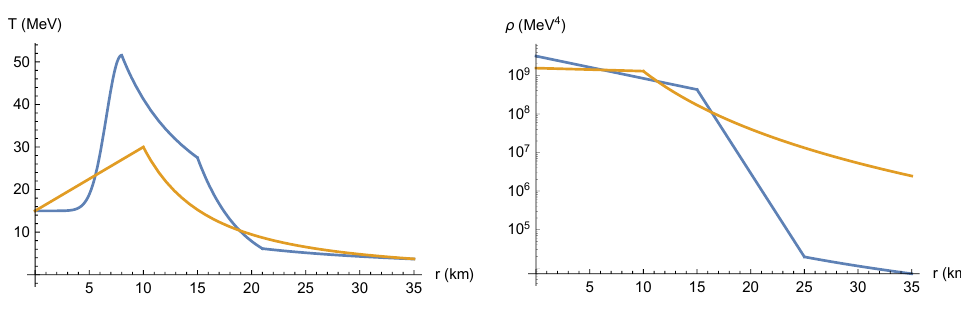
Figure 2 . The two SN pro(cid:12)les compared in order to assess the e(cid:11)ect of modeling uncertainties on our results. The yellow curve is the pro(cid:12)le used to generate our bounds while the blue curve is the one described in this appendix. Though the blue curve reaches a much higher temperature than the yellow curve, the overall e(cid:11)ect on our bounds is small. Note that the disagreement in densities at radii outside 20 km does not cause a signi(cid:12)cant discrepancy in our results because the majority of production occurs in the dense regions within the